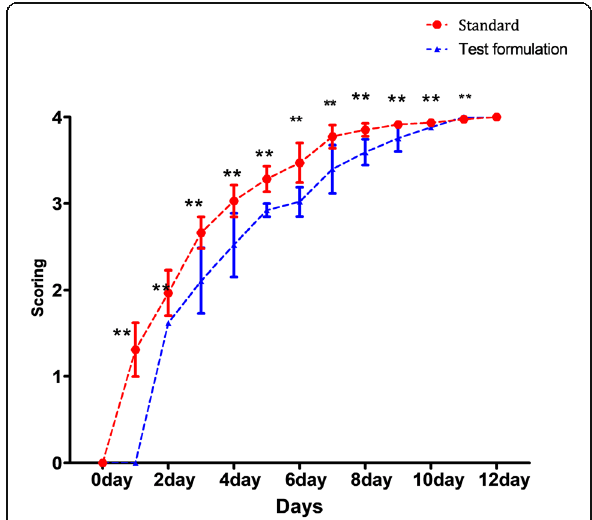
Fig. 2 Effect of extract on psoriasis score in rats. Each point indicates psoriasis score. ** P < 0.0001, # P < 0.0001 vs. STD treated rats